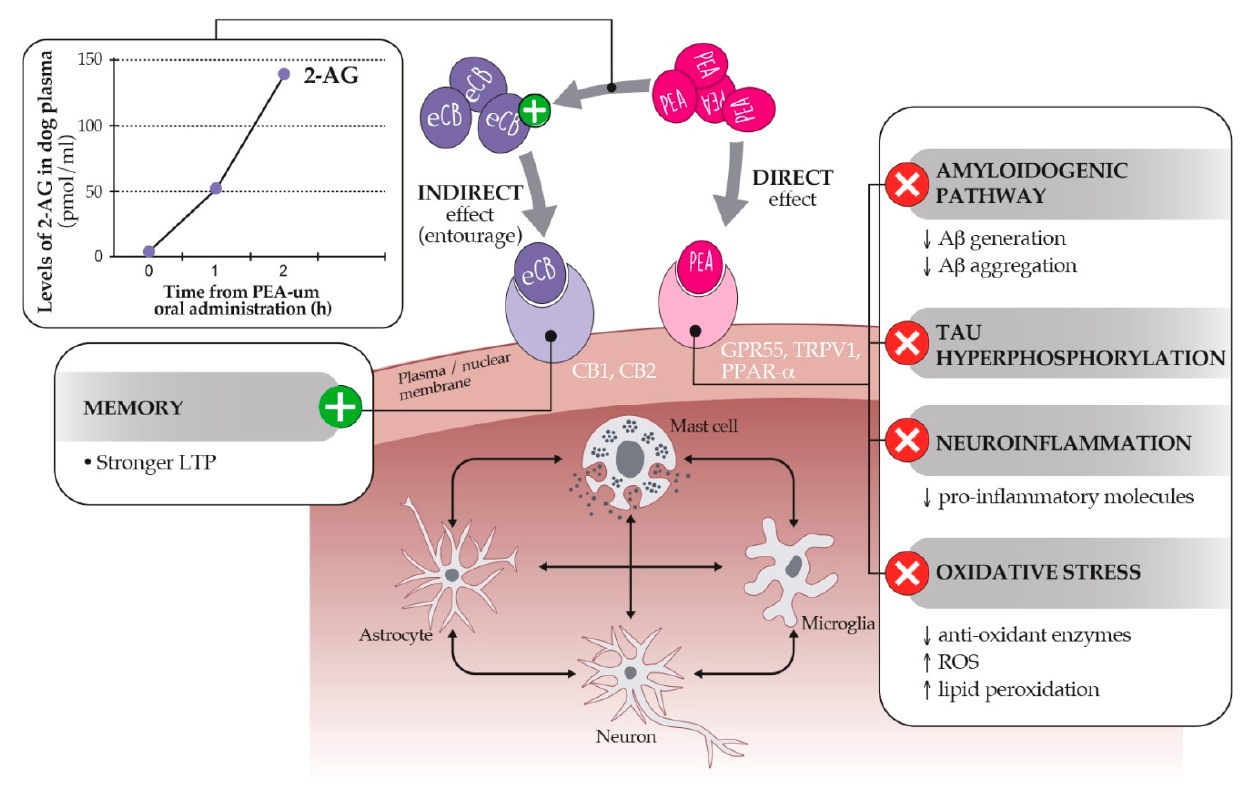
Figure 6. Proposed mechanisms of action of PEA. PEA exerts a direct and indirect agonism on the endocannabinoidome within brain cells. The direct pathway depends on the activation of GPR55, TRPV1, and PPAR- α receptors, the last inhibiting the hallmarks of age-related cognitive dysfunction (right panel). Through the so-called entourage effect, PEA may also increase the level (left panel) or the binding affinity of endocannabinoids for CB1 and CB2 receptors, favoring stronger LTP (Long Term Potentiation) and memory processes. See text for further details.